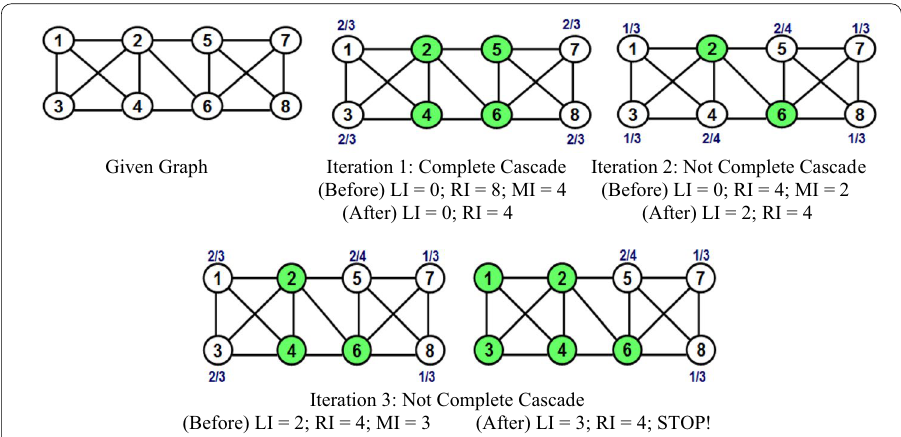
Fig. 2 Example to illustrate the execution of the binary search algorithm with the threshold fraction ( q of adopted